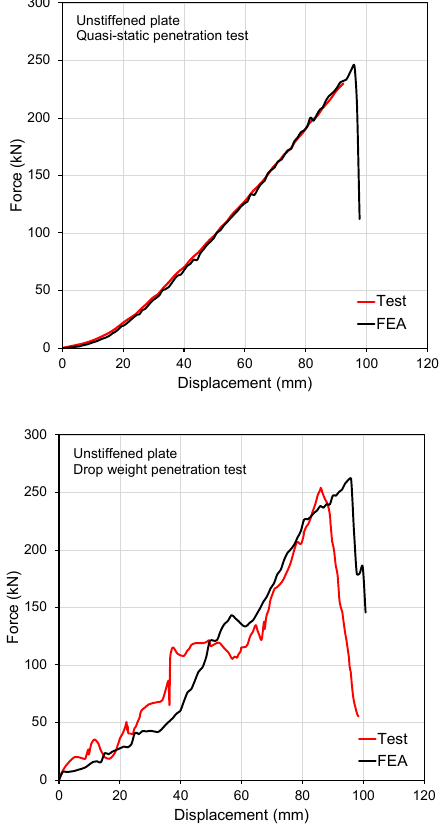
Figure 1. Force–displacement curves for the unstiffened plate simulations. In both quasi-static and dynamic simulations, failure was associated with localized necking. Figure 2 presents the localized necking indicator plot before and after fracture initiation, followed by the formation of petals. The predicted failure pattern was in good agreement with the post-mortem test model photo reported elsewhere [31]. Fracture initiated around the necking circle at multiple locations. This was followed by the